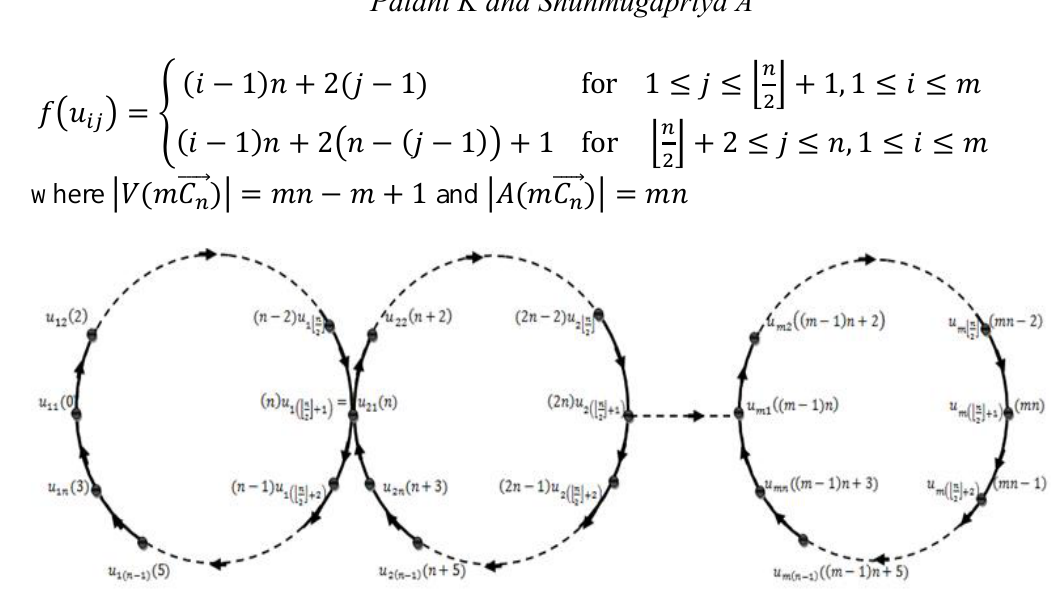
⃗⃗⃗⃗ when 𝑛 is even 𝑛